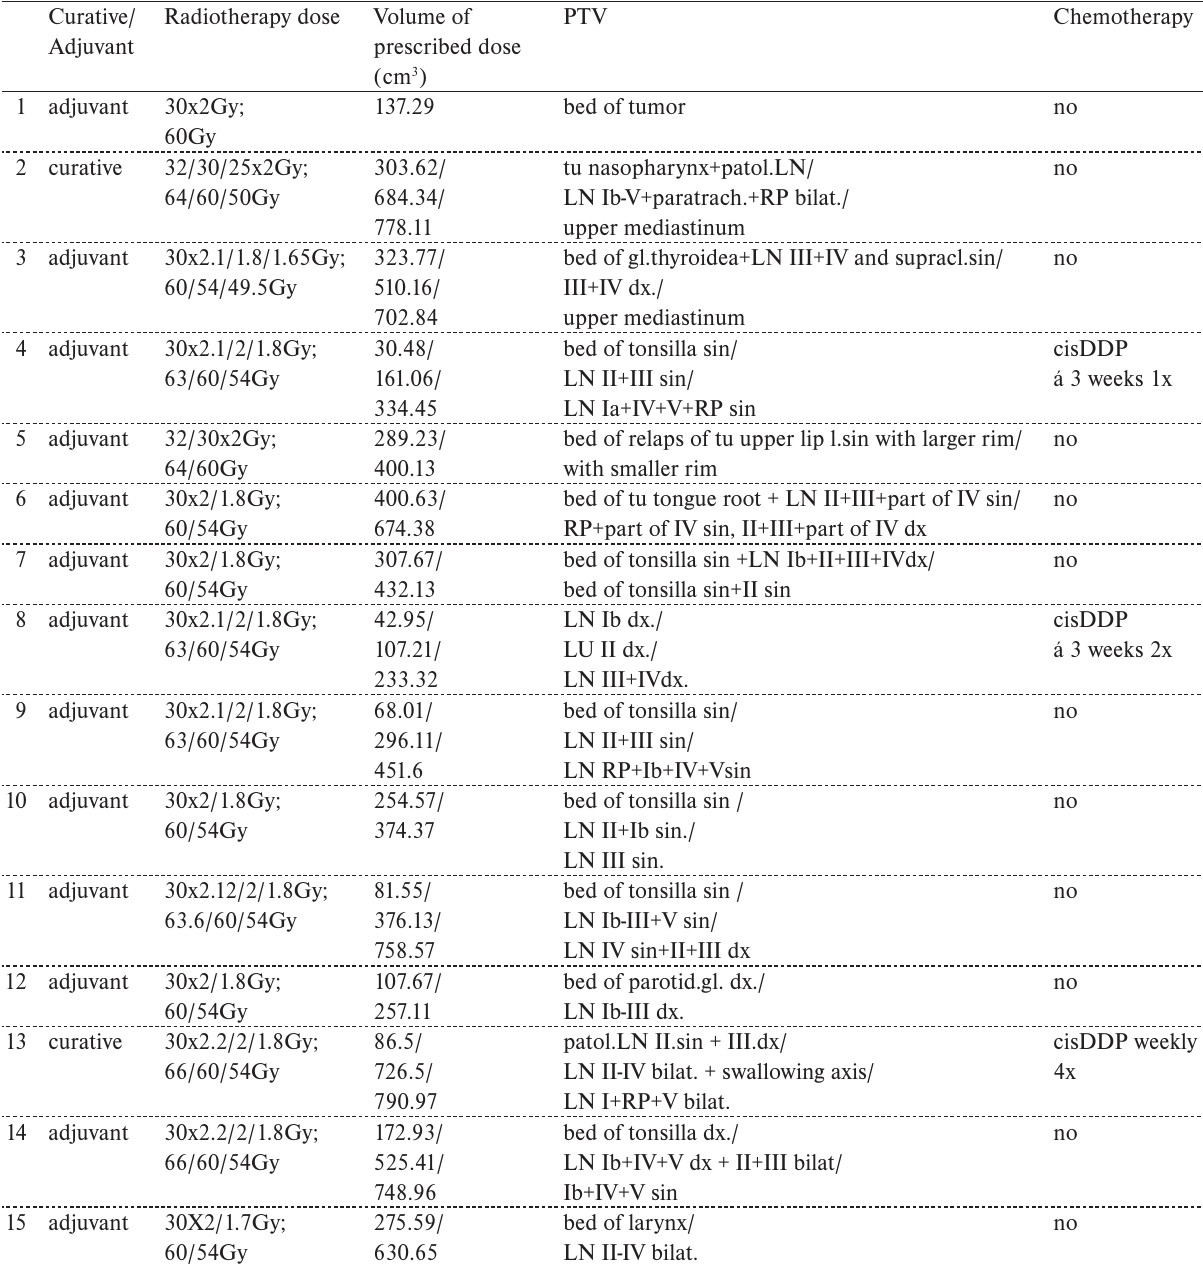
Table 2. Individual characteristics of patients from acupuncture arm: type of treatment, dose, volume of radiotherapy, target volume definition (PTV), chemotherapy.